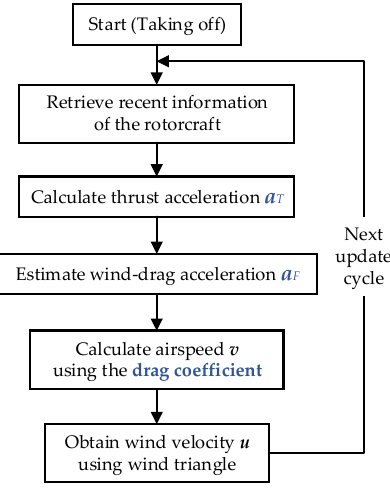
Figure 3. Scheme of the wind estimation method.